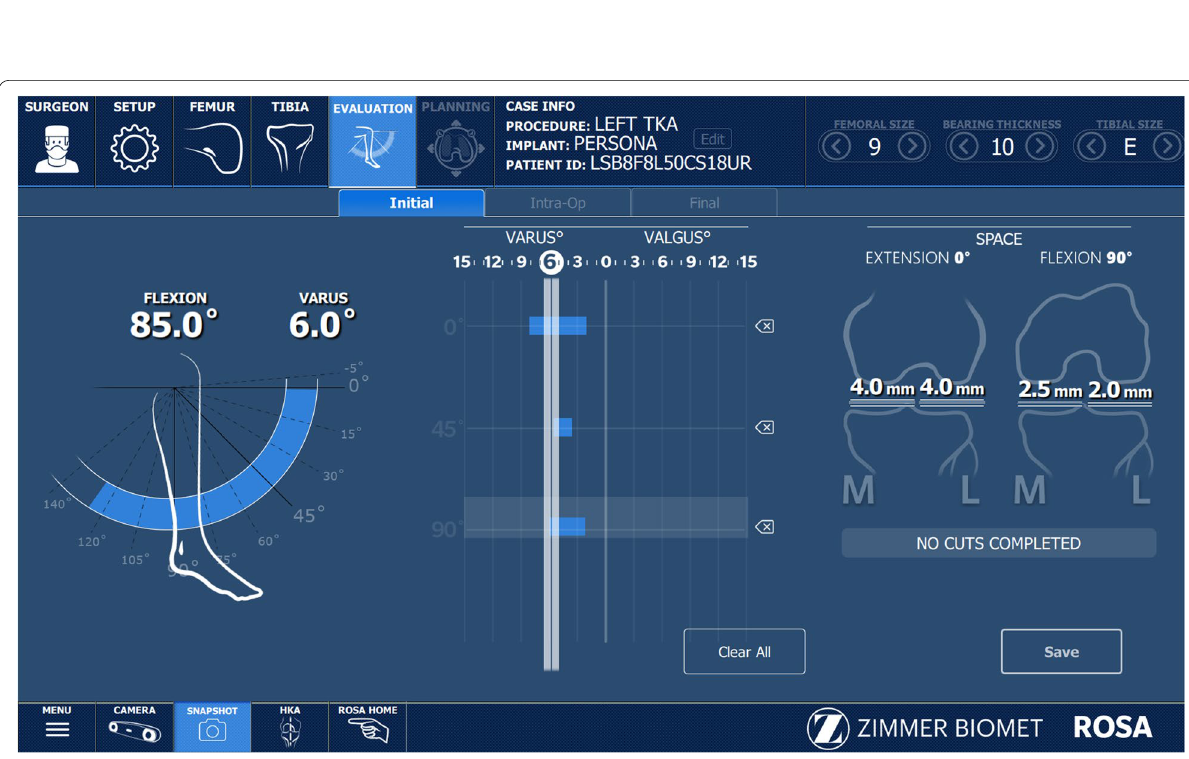
Fig. 5 An intraoperative image demonstrating the assessment of range of motion and ligament laxity both medially and laterally by the robotic